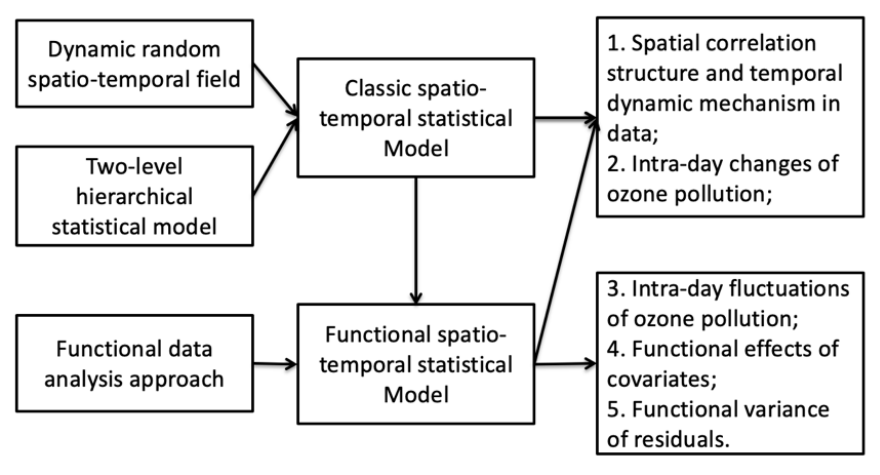
Figure 4. Methodology